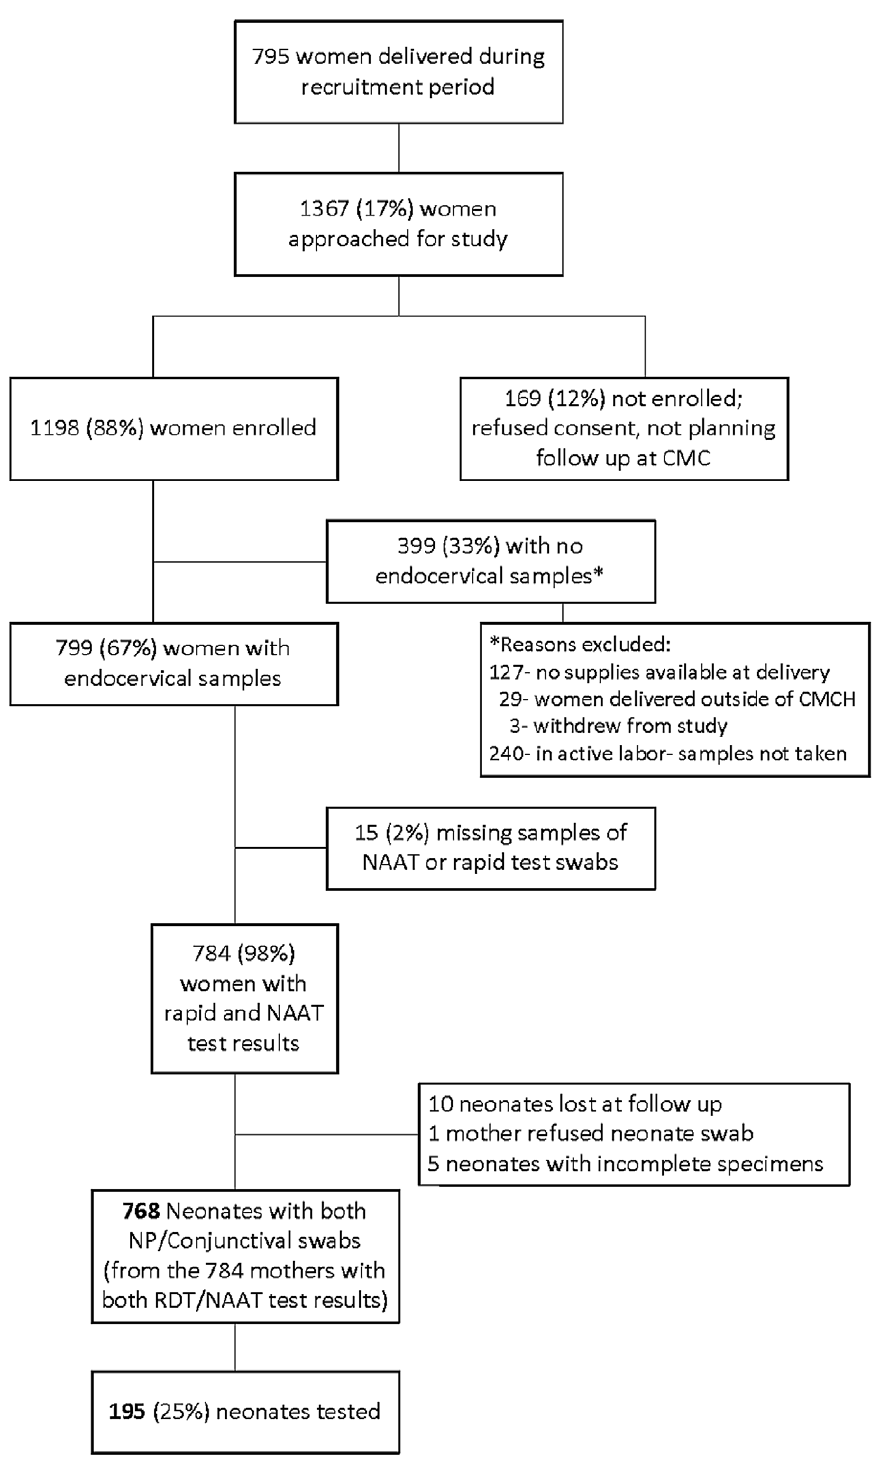
Figure 1. Study Flow Chart. April 2009 to January 2010, 7955 women delivered during the recruitment period. 1198 (88%) women were enrolled; 799 endocervical samples from the 1198 enrolled subjects were collected and data on 784 participants with both RDT and NAAT results are reported. doi:10.1371/journal.pone.0034794.g001 including NP and conjunctival swabs, were negative; including the infant of the mother with the positive endocervical NAAT result. The neonate born to the NAAT positive mother did not have any neonatal problems.